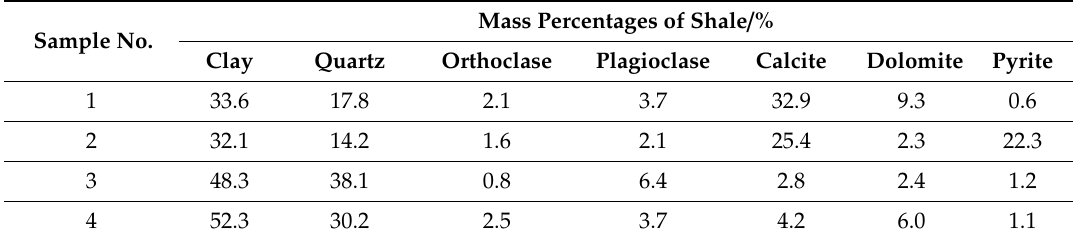
Table 1. Total mineral composition of shale in the Longmaxi